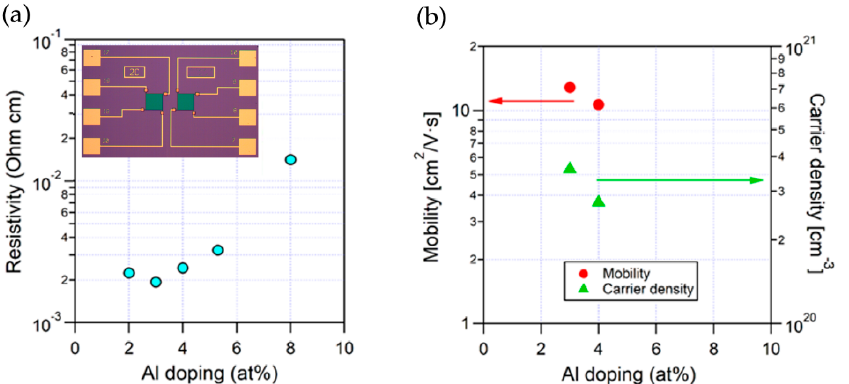
Figure 6. ( a ) Electrical resistivity of the five samples characterized using a Hall bar device realized by optical lithography (the device architecture is shown in the inset). ( b ) Carrier mobility and density for the samples with Al doping 3 at.% Al and 4 at.%.